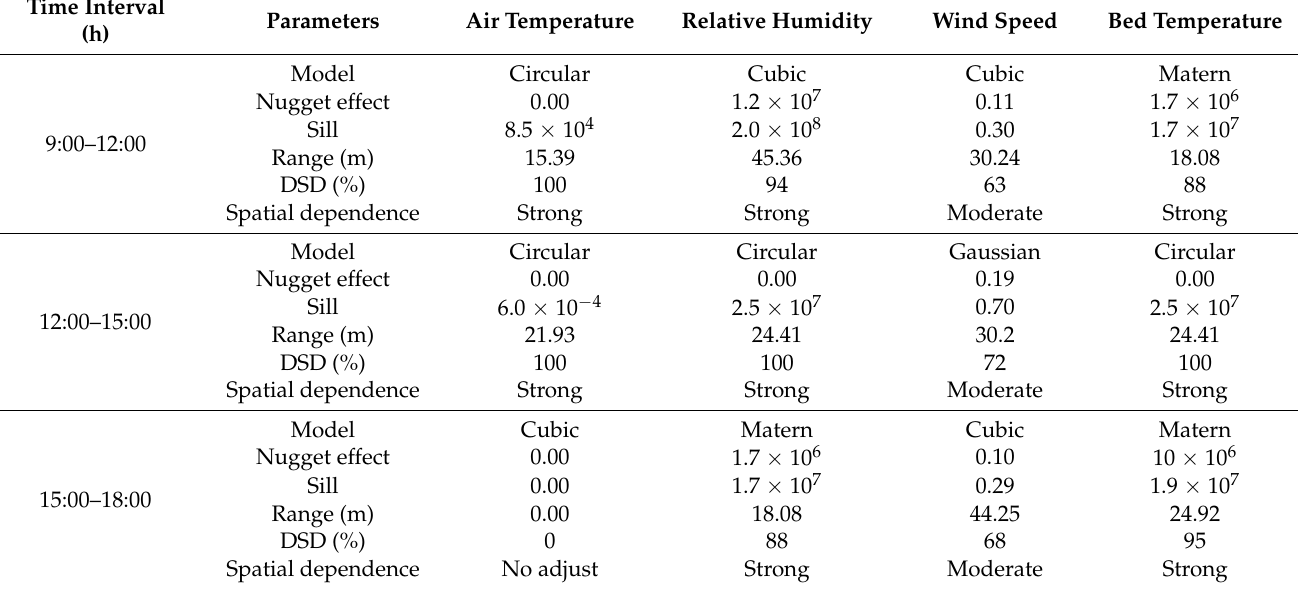
Table 3. Geostatistical models and adjusted parameters of experimental semivariograms for air temperature, relative humidity, wind speed, and bed temperature. Time Interval